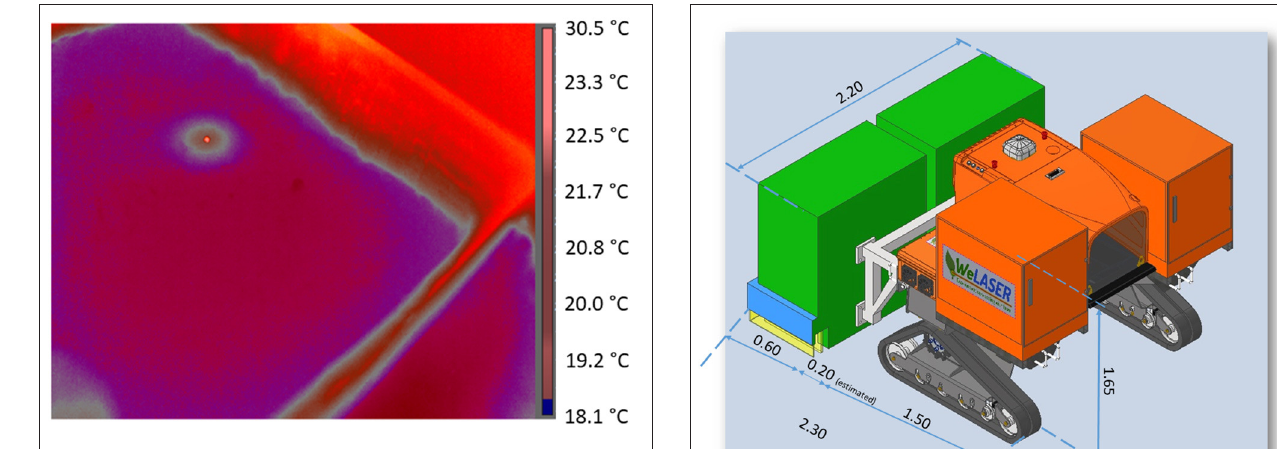
necessary to control weeds several times in the season. However, weed species have different temperature requirements for seed germination. Therefore, it is likely that if seeds from weed species with higher temperature requirements (e.g., Solanum nigrum